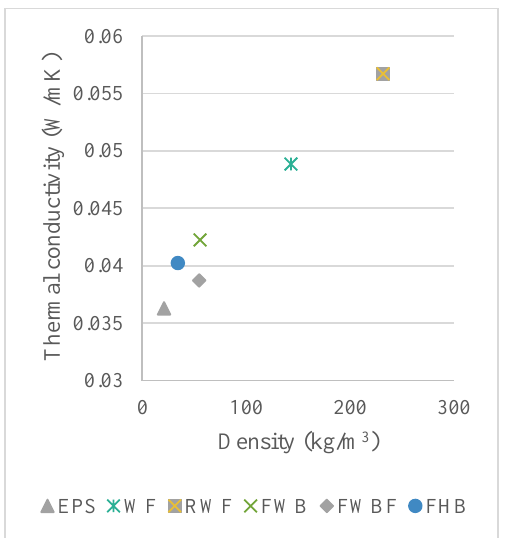
Figure 1. Relationship between the density and thermal conductivity of bio-based insulations and EPS. Buildings 2020 , 10 , x FOR PEER REVIEW